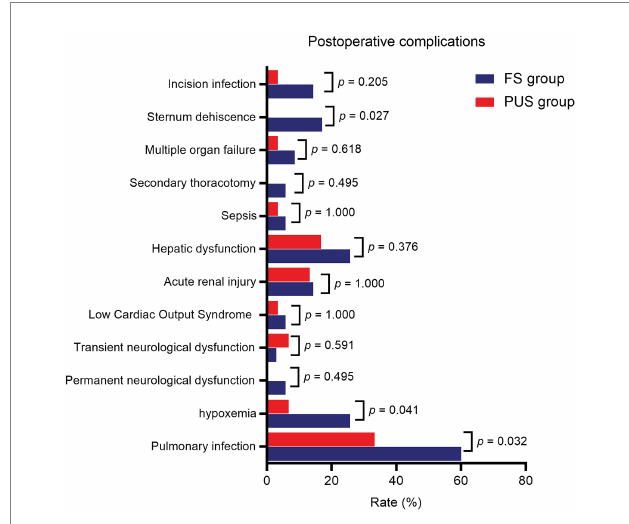
FIGURE 7 Postoperative complications of patients in two